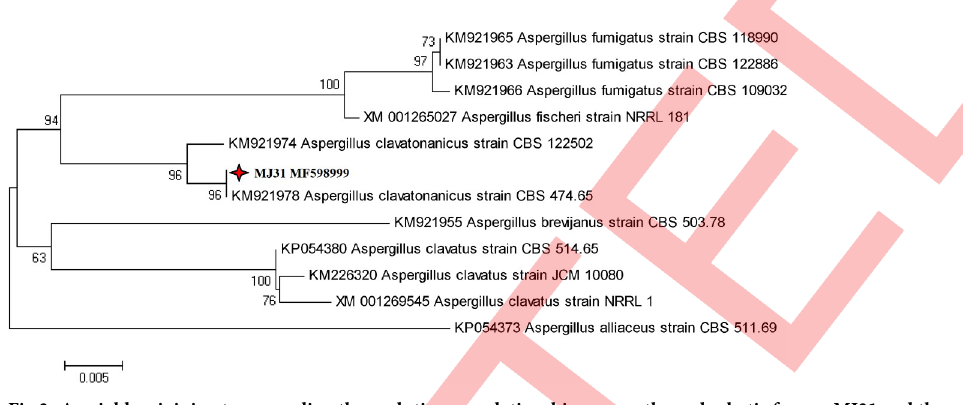
Fig 3. A neighbor joining tree revealing the evolutionary relationship among the endophytic fungus MJ31 and the BlastN analysis along with the ten type strains retrieved from NCBI GenBank databases based on elongation factor Iˆ± (EF-Iˆ±) sequences. The bootstrap values were depicted based on 1000 replications, whereas Aspergillus alliaceus strain CBS511.69 was taken as an